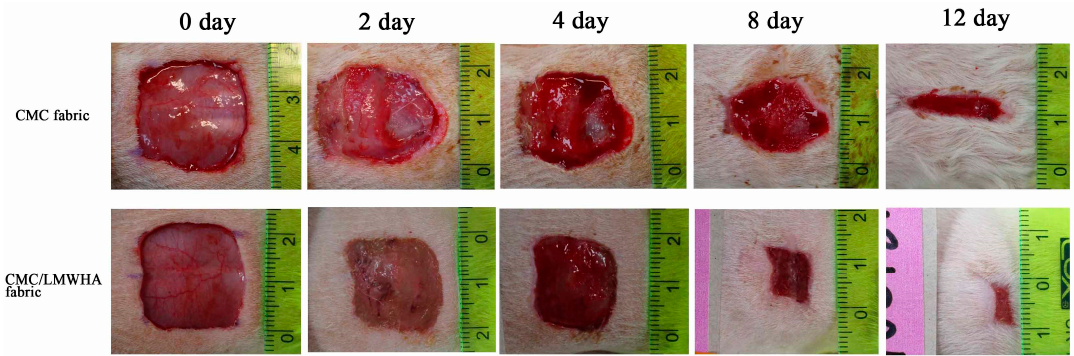
Figure 7. Photographs of the wound in rats after skin excision on days 0, 2, 4, 8 and 12.